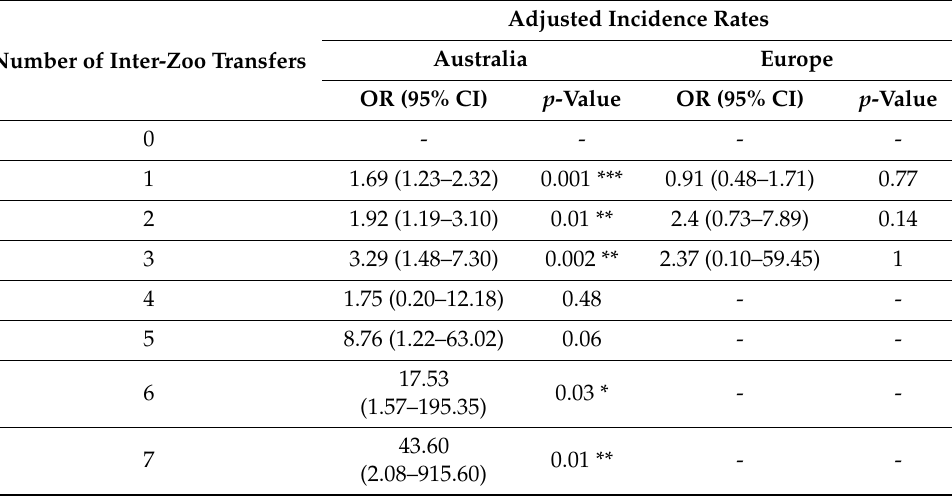
Table 4. Odds ratios and 95% CI for inter-zoo transfers in relation to risk of developing MPPD in macropods housed in zoological institutions in the Australian and European regions between 1 January 1995 and 28 November 2016. Reference category: macropods that had no inter-zoo transfers.